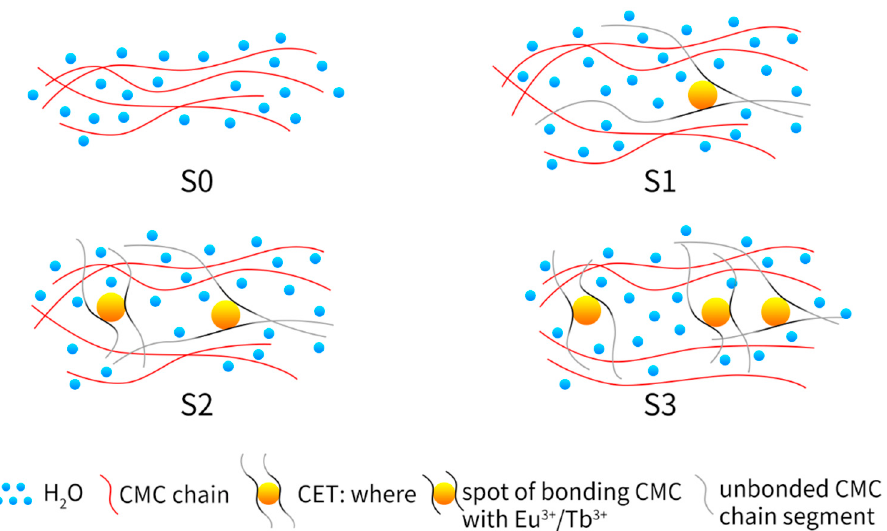
Figure 6. The mechanism diagram of entanglement between the CMC chain and the unbonded chain segment in CET macromolecule during the drying process.